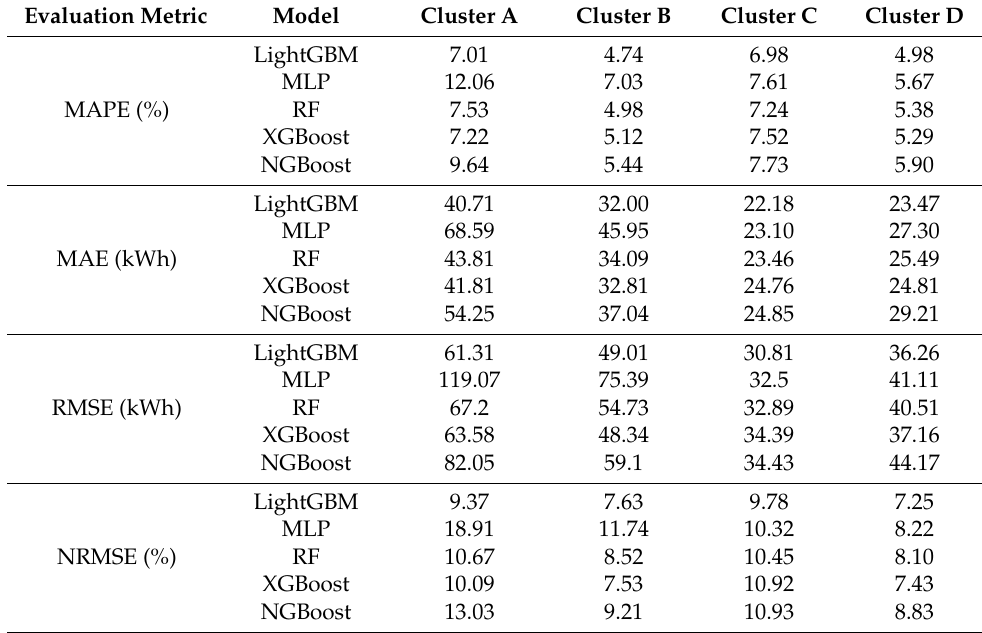
Table 4. The comparative experimental results of single-output forecasting models. Evaluation